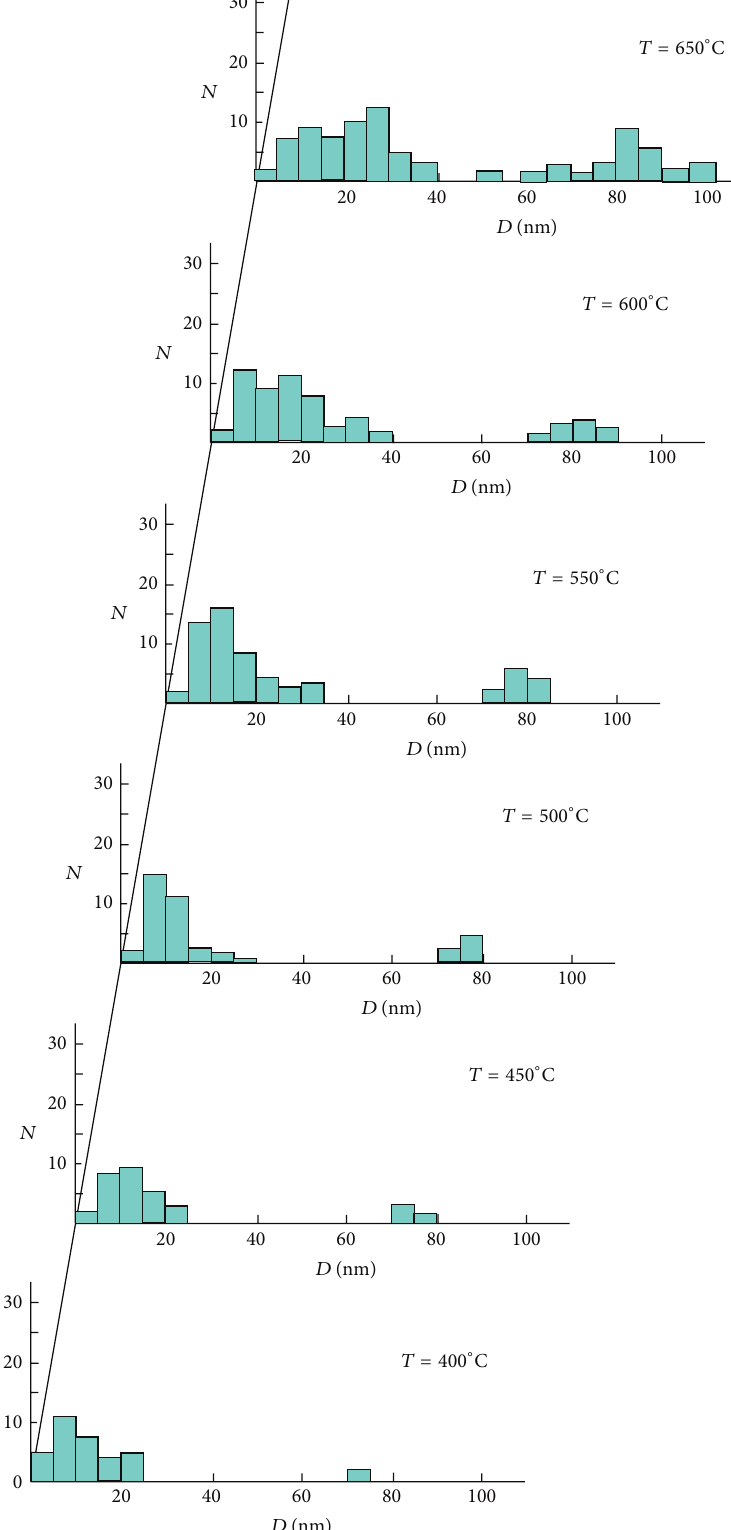
Figure 5: Size distributions of InAs nanoislands at different substrate temperatures, where 𝑁 is a number of